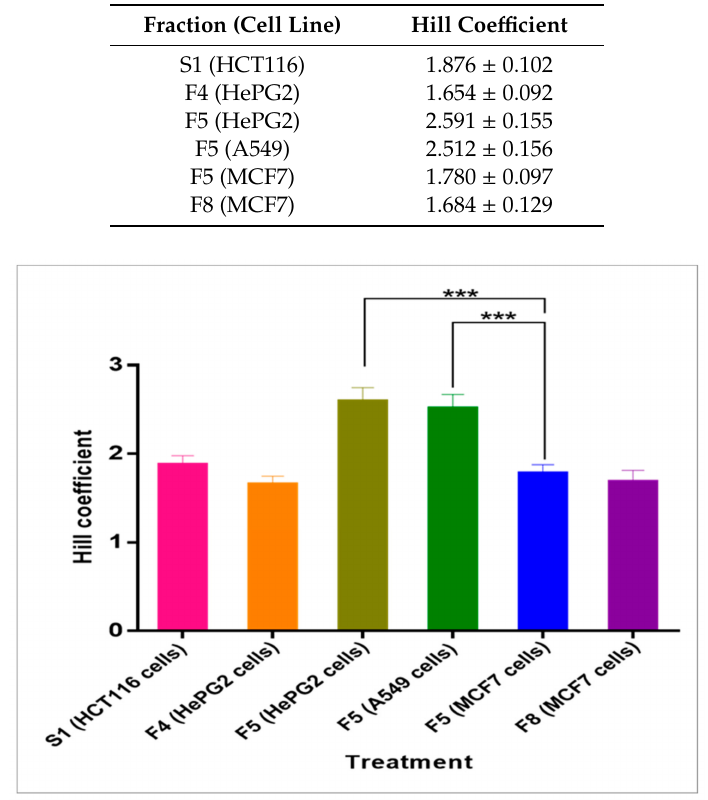
Table 5. Hill coe ffi cients for fractions that showed lethality ≥ 75%.